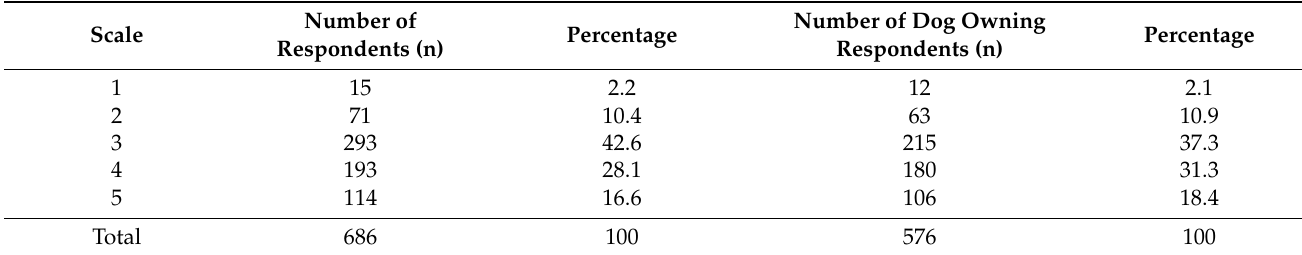
Table 4. How much exercise have their pets been getting during lockdown compared with pre-lockdown using a Likert-like scale from 1 “A lot less”, through to 5 “A lot more”.